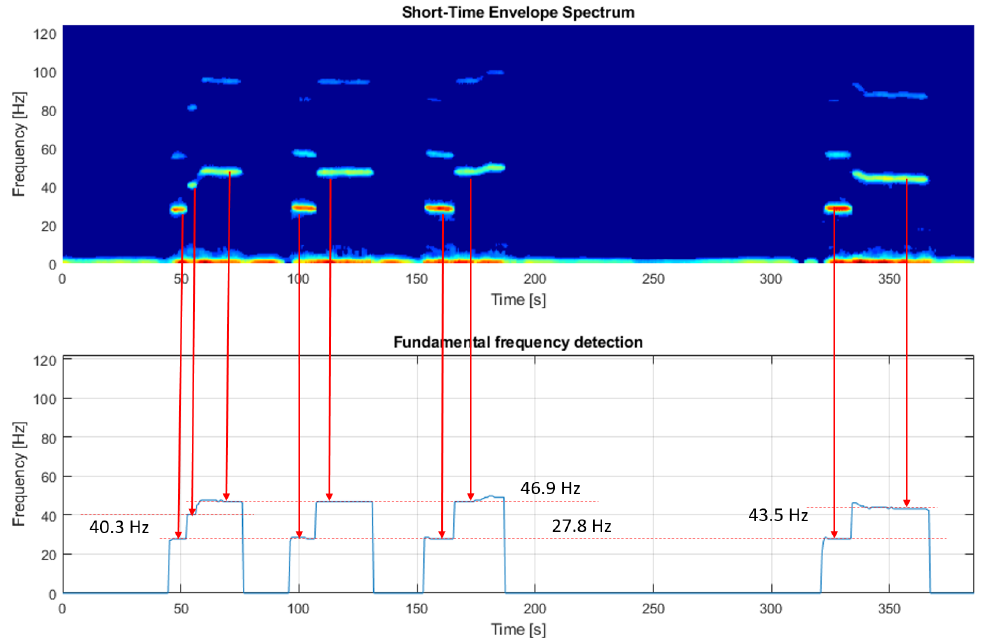
Figure 13. Results of audio signal analysis using the segment presented in Figure 11. The short-time envelope spectrum (in the top panel) allows us to observe the spectral structure of the modulation caused by the energy variation generated by percussion. Further processing allows us to extract and track the fundamental frequency of percussion (bottom